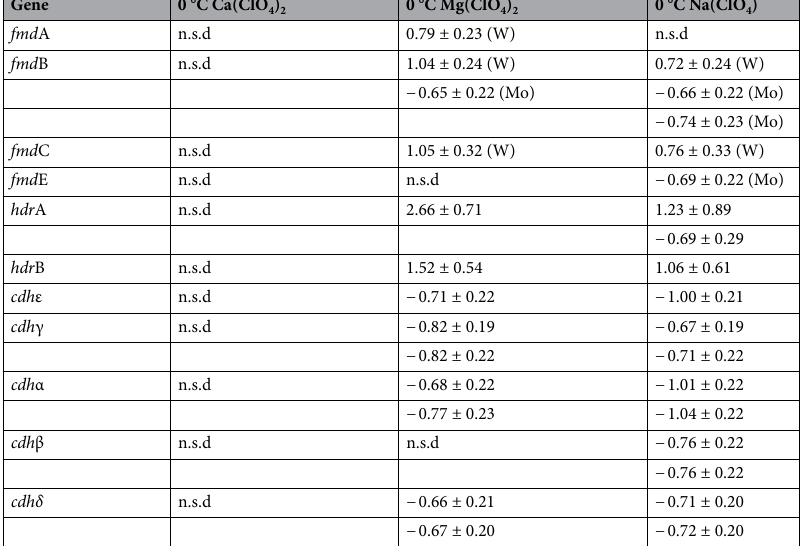
Table 2. Differential expression (Log 2 -fold change ± standard error) of M. barkeri MS genes implicated in the Wood-Ljungdahl pathway and hydrogenotrophic methanogenesis. LFC is for 0 °C and